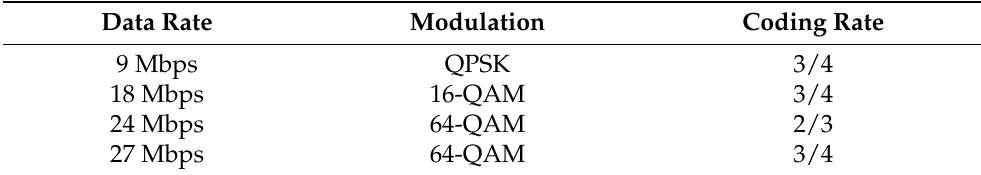
Table 2. Parameters used in the IEEE 802.11p data